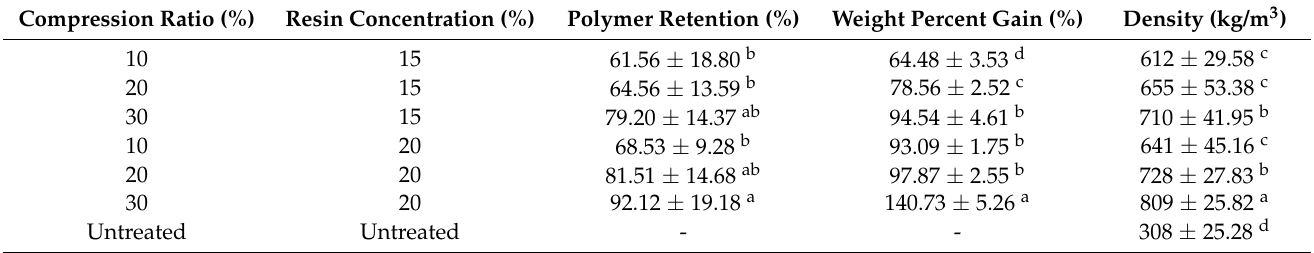
Table 3. Polymer retention, weight percent gain and density of inner oil palm wood treated at different compression ratios and resin